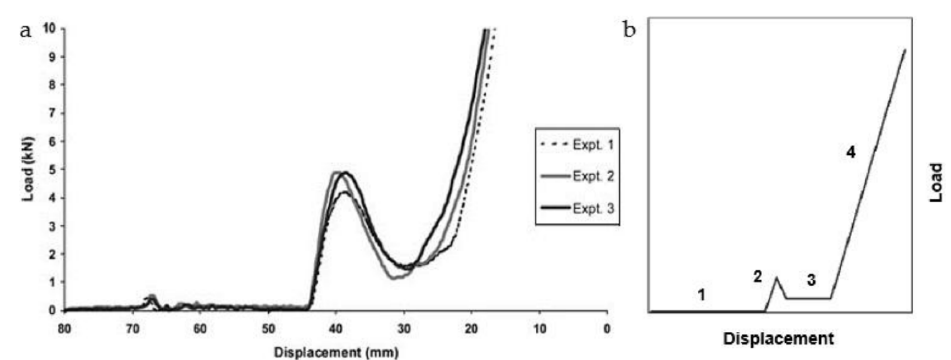
Figure 7. ( a ) Typical signal response to rapid compression of semi-solid A356 alloy (ram speed: 500 mm/s; soak time: 0 min; and temperature 575 ◦ C) [44]; ( b ) Schematic appearance of a load vs. displacement response. Four distinct regions are present: (1) zero load prior to reaching the die; (2) an initial breakdown, or peak load (stress); (3) a relatively constant, or plateau, load after the initial breakdown; and (4) a rapid increase in the load as the die approaches complete filling